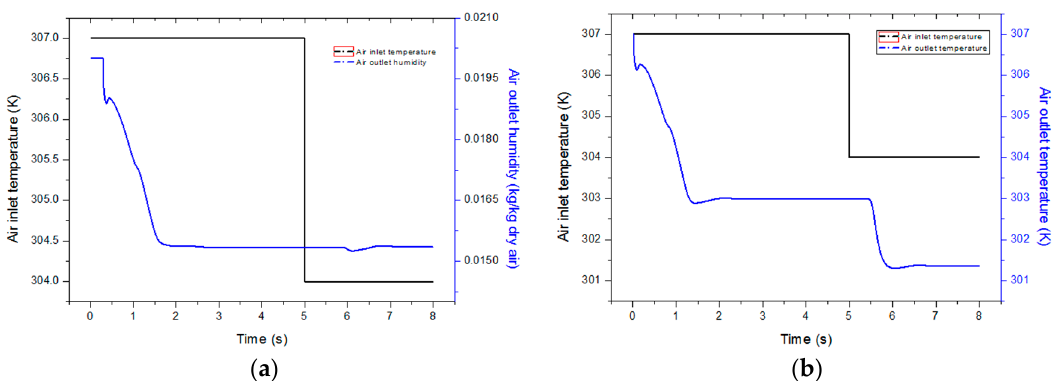
Figure 1. Humidity and temperature variation under step change of air temperature. ( a ) air outlet humidity; ( b ) air outlet temperature.